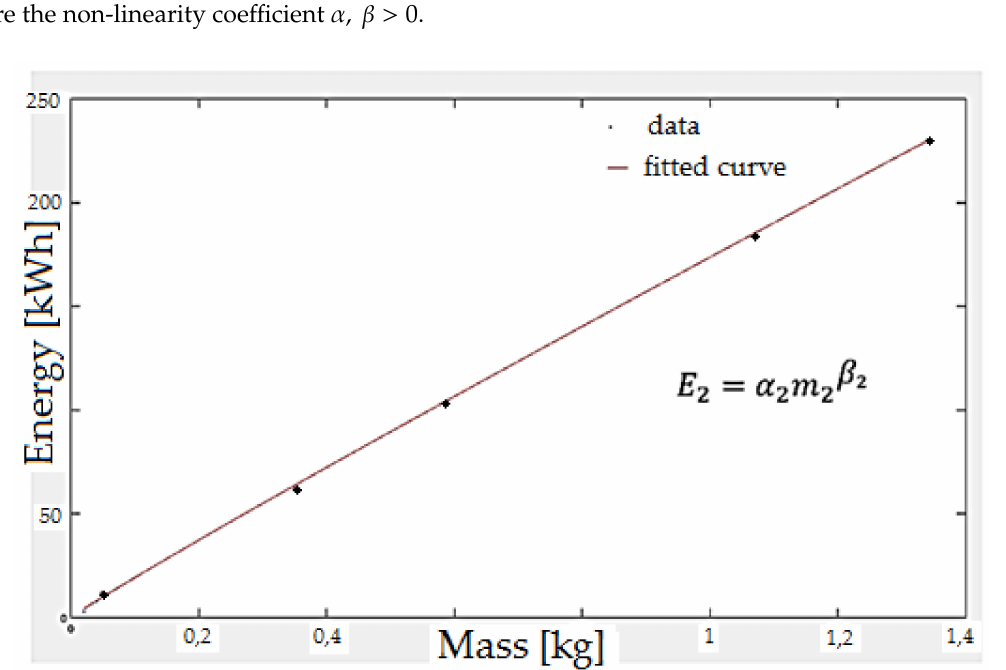
Figure 2. Non-linear relationship between energy and mass (Li-ion battery) with a fitted curve calculated in the Matlab environment. Coe ffi cient α and β are given in Section